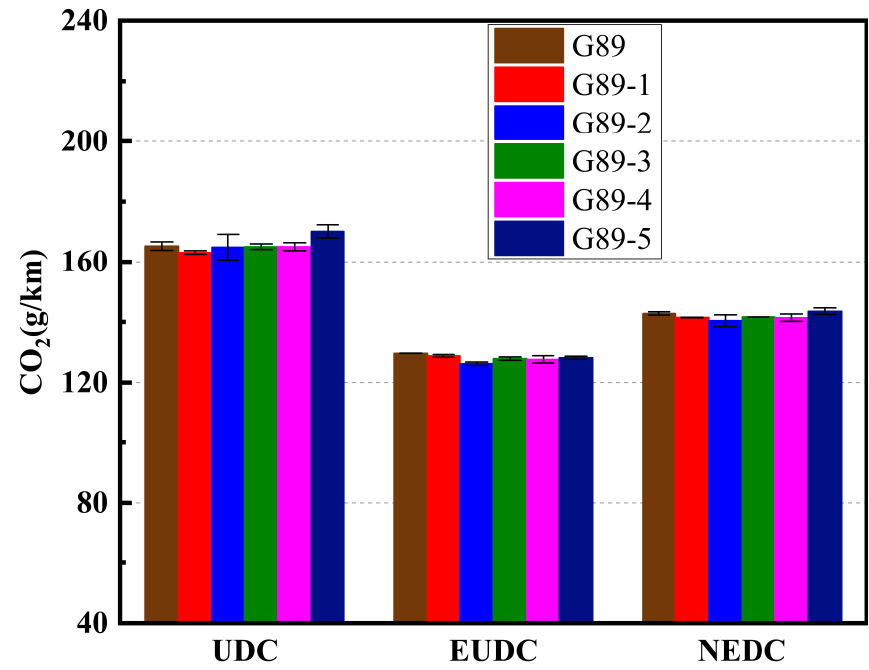
Figure 4. The CO 2 emissions of the PFI vehicle when fueled with the different fuels.